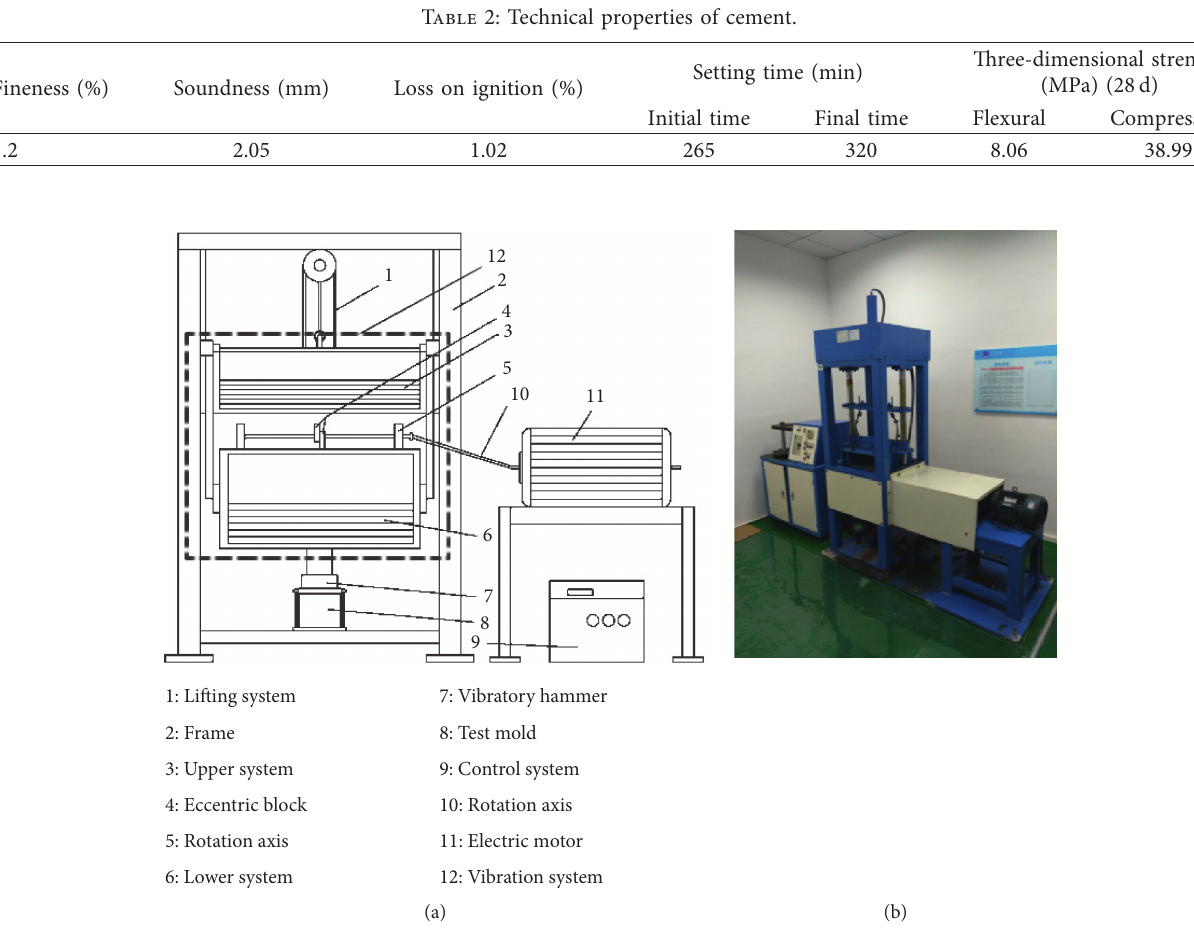
Figure 1: (a) Diagram of VVTE; (b) photograph of VVTE in laboratory.